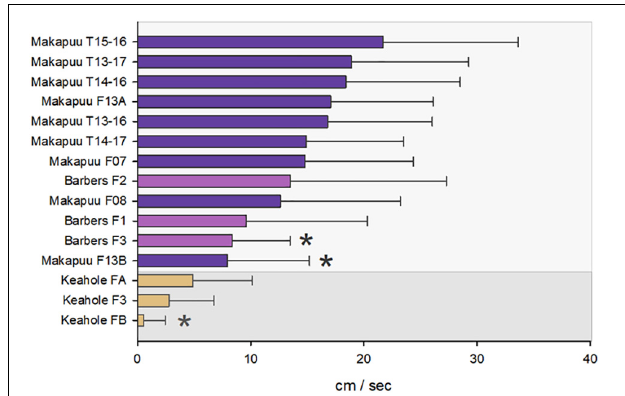
FIGURE 6 | The mean and standard deviation of the 15 flow and tiltmeters placed in the three patches with Makapu‘u Pt. values clustered at the top, Barbers Pt. in the middle, and Keahole Pt. at the bottom. The asterisks indicate an instrument at the edge of the coral patch. The darker shaded background represents the greater scatter strength ( − 24 dB) of the Keahole Pt. water mass over the other sites ( − 42 dB).